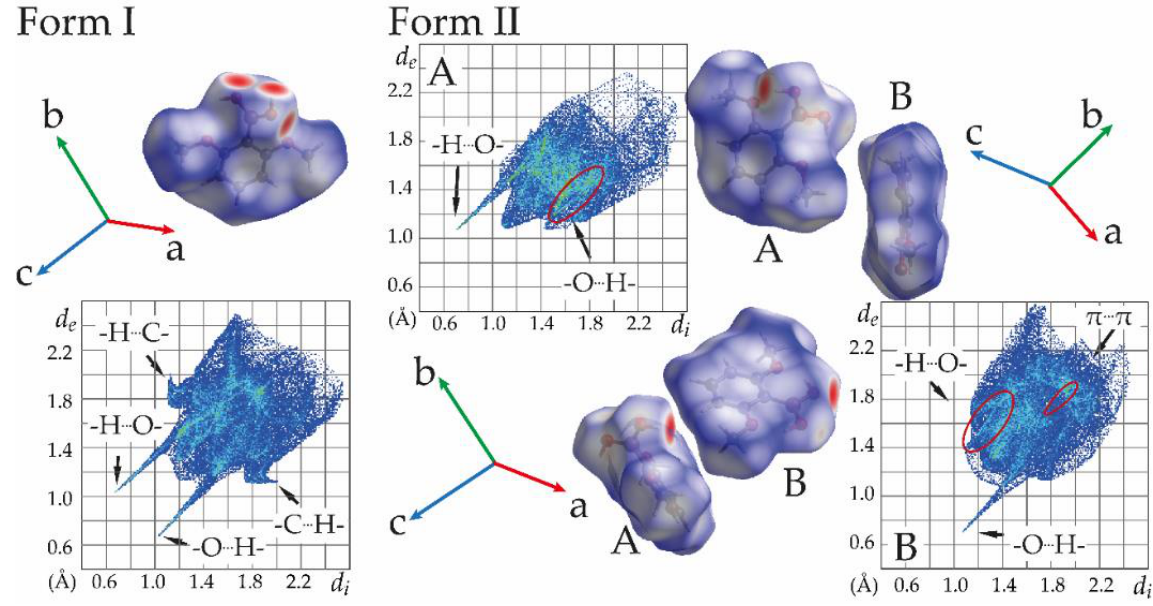
Figure 8. Hirshfeld surfaces and their 2D fingerprinting plots of MPBA Forms I and II. In the labels, the atom on the left is inside the Hirshfeld surface.